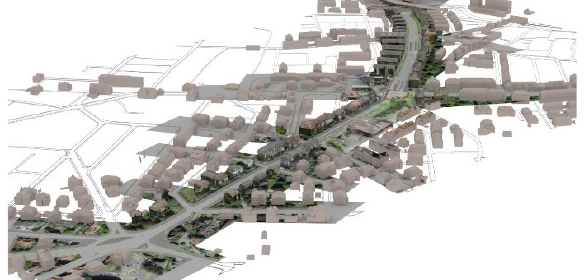
Figure 10. The resulting Model ready for VR application.